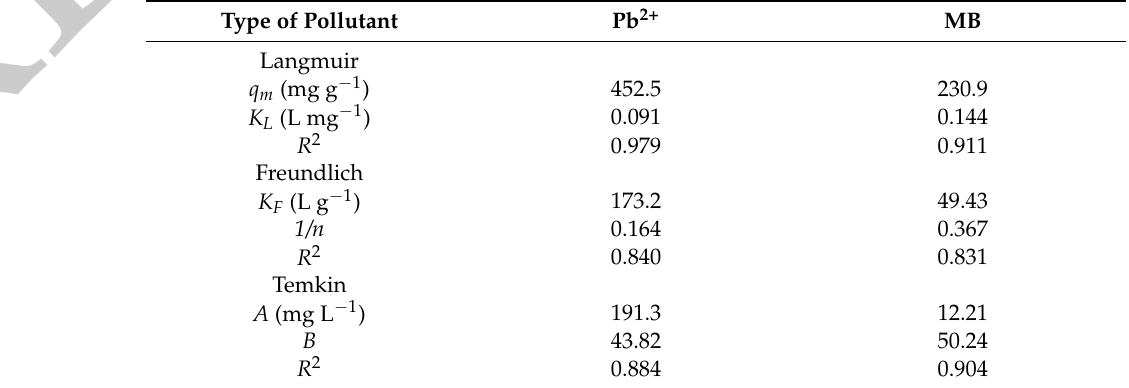
Table 2. Isotherm parameters of the adsorbents for Pb 2+ and MB.